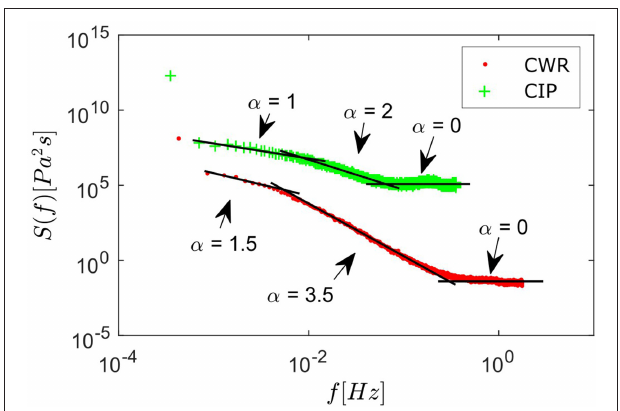
FIGURE 13 | Power spectral density of the pressure signal for CWR (red dots) and CIP (green crosses) boundary conditions, the later being shifted upwards 4 orders of magnitude. Both systems present scaling behavior for the PSD of f − α , with different exponents α shown by the guide-to-eye lines. the form S ∝ In both cases, the spectra for high frequencies present the typical flat profile characteristic of white noise from the experimental measuring device. Notice that for the CIP case, a region consistent with 1 / f scaling (pink noise) for the low-frequency events is observed, followed by a 1 / f 2 (brown noise) region for intermediate